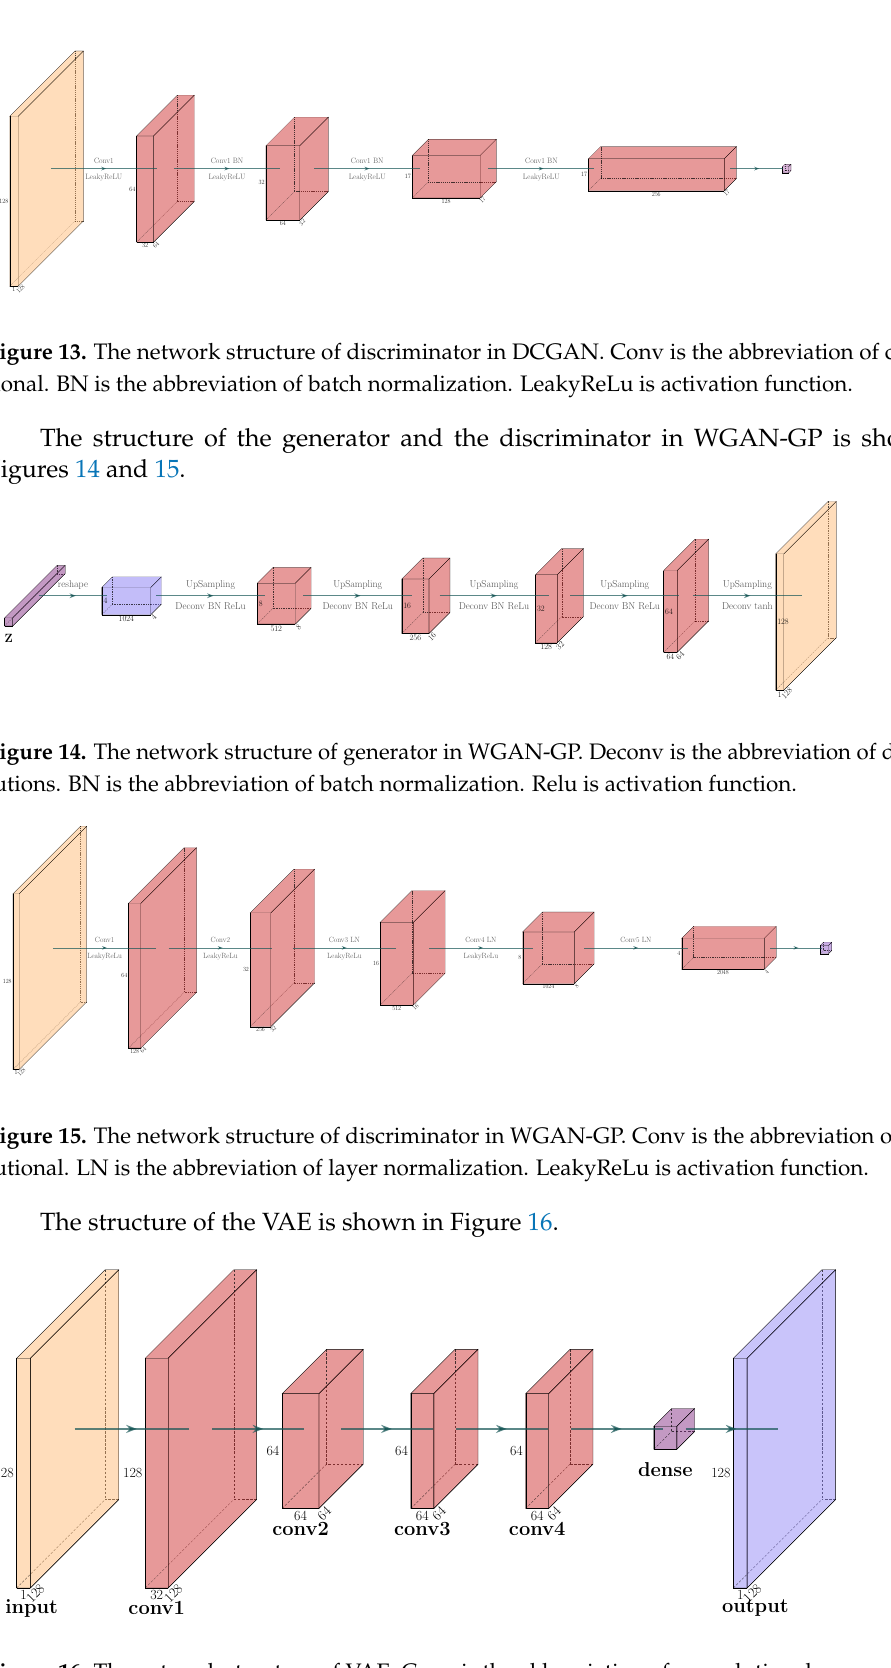
Figure 16. The network structure of VAE. Conv is the abbreviation of convolutional. Both generators have a tanh function in the last layer. And there is a sigmoid function in the DCGAN discriminator’s last layer. In all figures, Conv is the abbreviation of